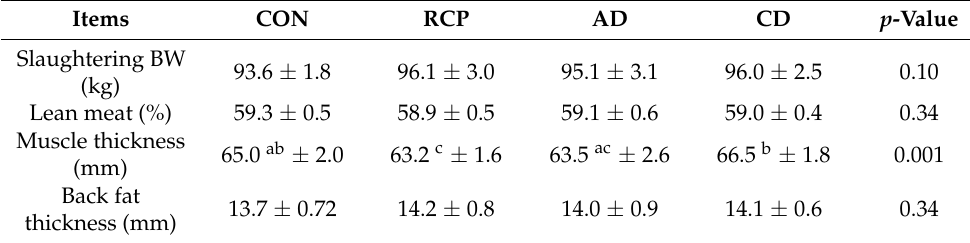
Table 4. Effects experimental diets on meat performance (mean ± standard deviation, n =